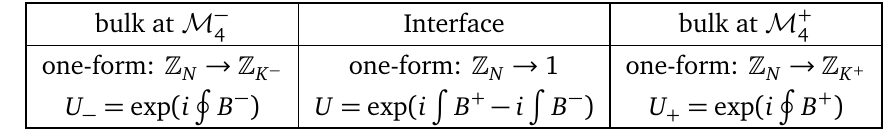
Table 4: The emergent global symmetry in a 4d system with an interface. The first row summarizes the symmetries and their spontaneous breaking. The second row presents the charge generators. In U the integral is over a closed surface that pierces ± = 1 means that this symmetry is broken to (cid:90) the interface. U L . Below we will ± K ± study an effective theory on the interface by performing a quotient of the full 4d-3d system by the bulk modes. We will see that the one-form global symmetry of this = (cid:90) effective theory is (cid:90) . N / lcm ( L + , L − ) gcd ( K + , K − ) + − bulk at Interface bulk at 4 M M